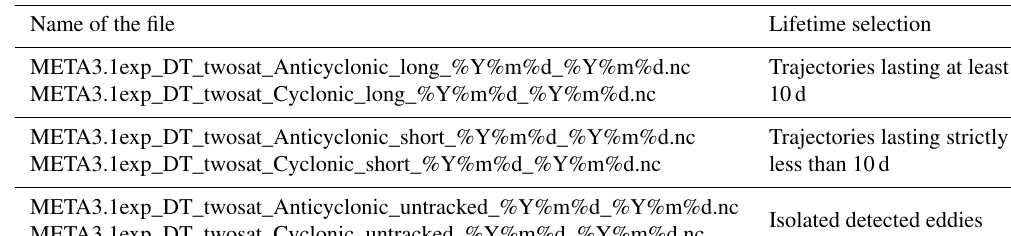
Table 4. Nomenclature of the META3.1exp DT two-satellites NetCDF files.